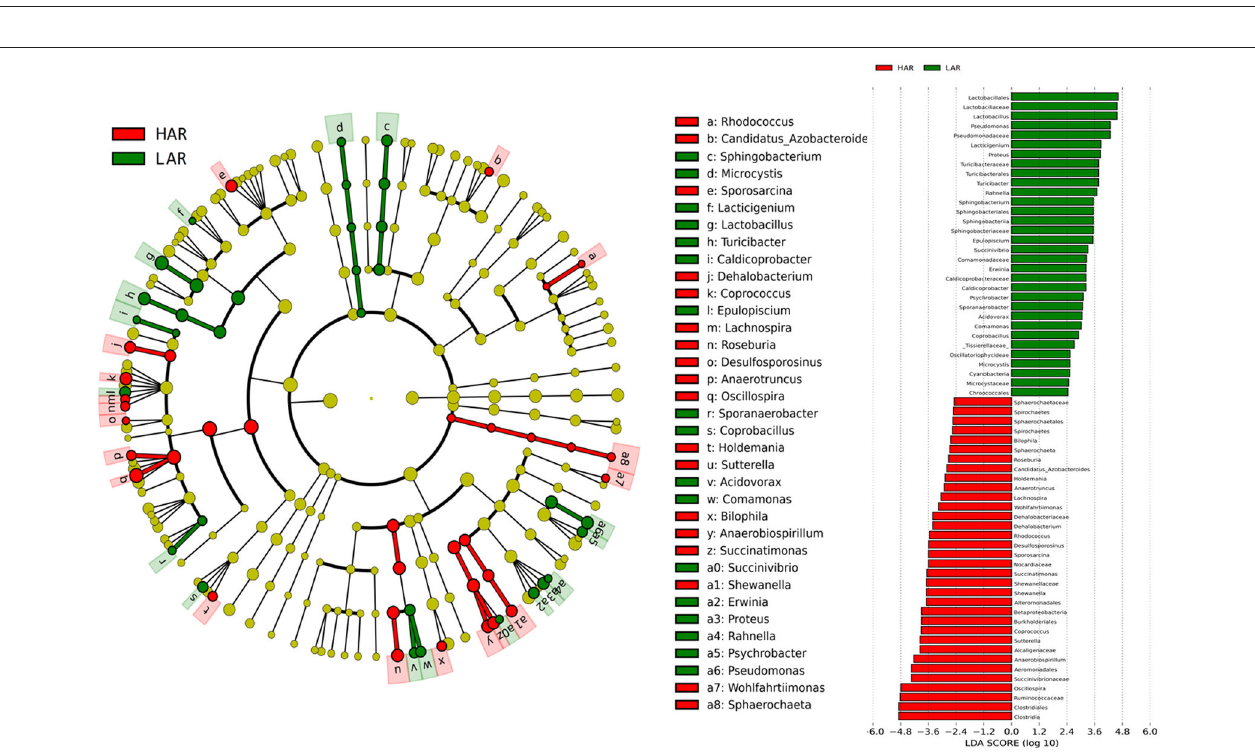
FIGURE 3 | LEfSe identified taxons forHAR and LAR. (Left) Taxonomic cladogram. Taxa enriched in HAR or LAR are colored by red or green, respectively. (Right) HAR-enriched taxa are shown with a positive LDA score (green), and taxa enriched in LAR are shown with a negative score (red). Only taxa meeting an LDA significant threshold > 2 and p < 0.05 are